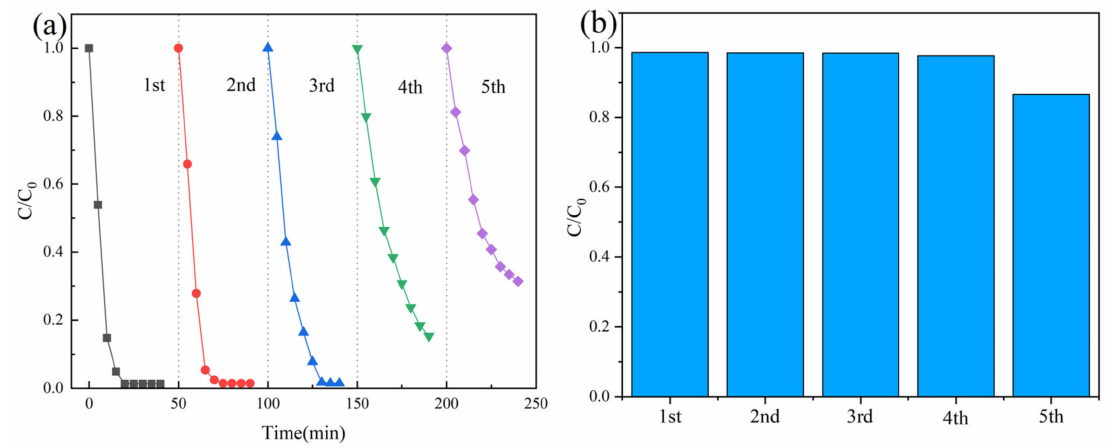
Figure 14. Recyclability for the degradation of CQP ( a , b ). (Experimental